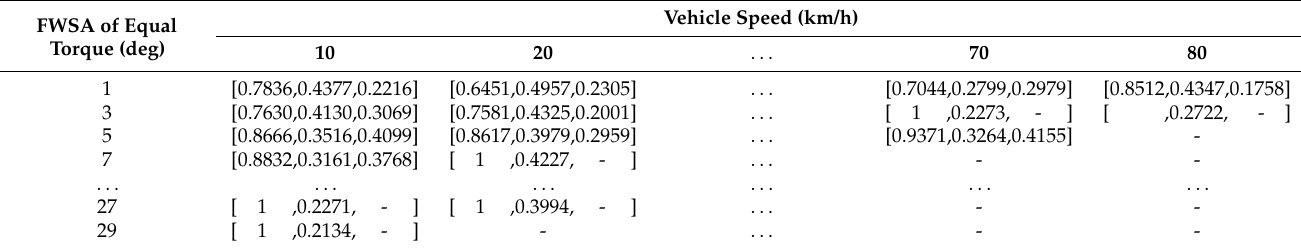
Table 2. Torque distribution coefficient of 10–80 km/h